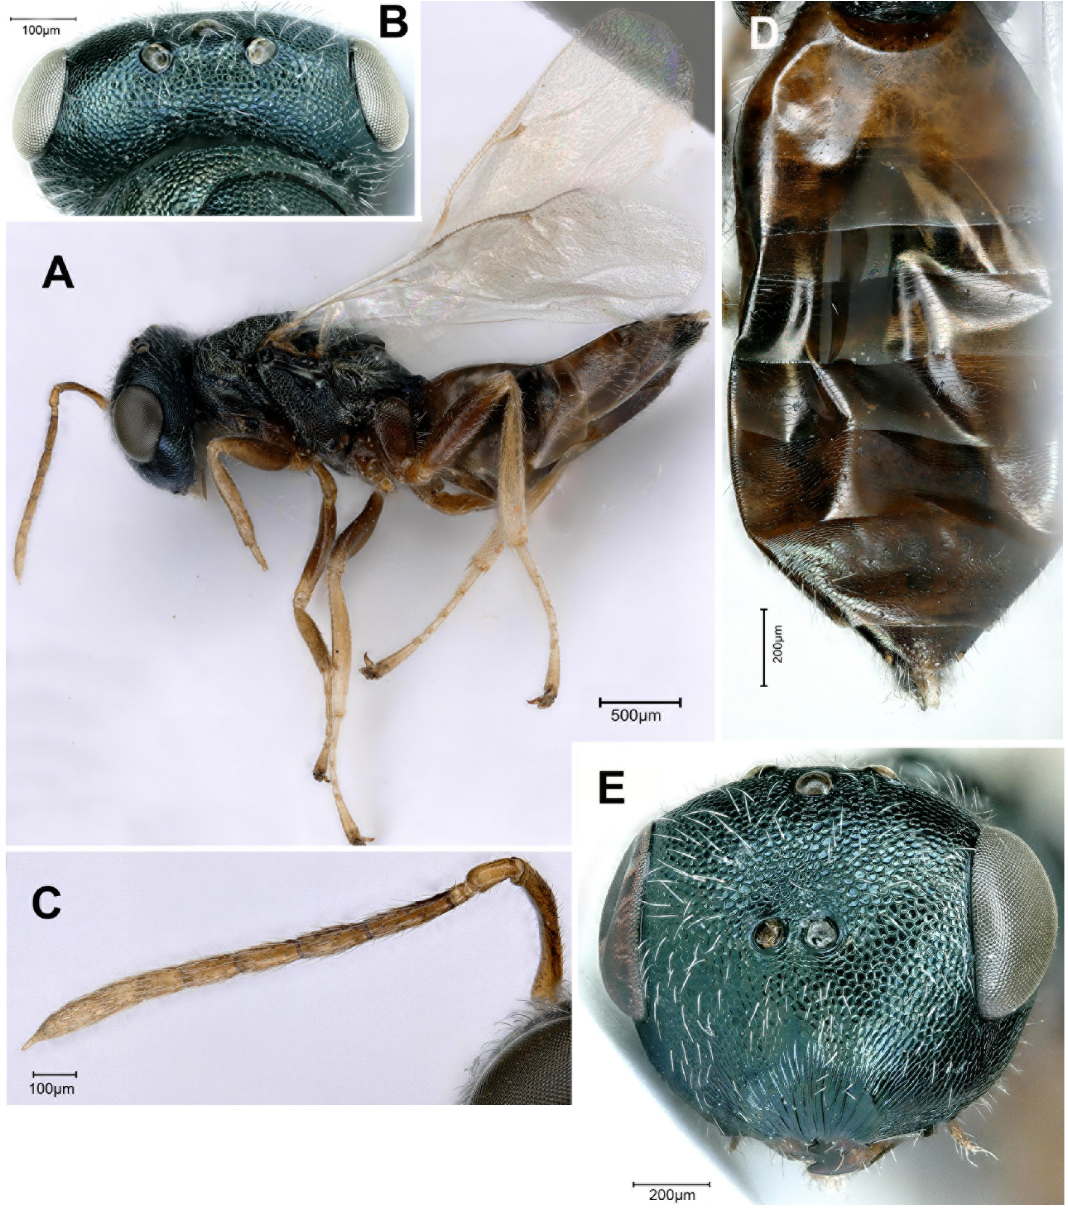
Fig. 13. Norbanus persicus Lotfalizadeh & Rasplus sp. nov., paratype, ♀ (HMIM). A . Lateral view. B . Head in dorsal view. C . Antenna. D . Metasoma in dorsal view. E . Head in frontal